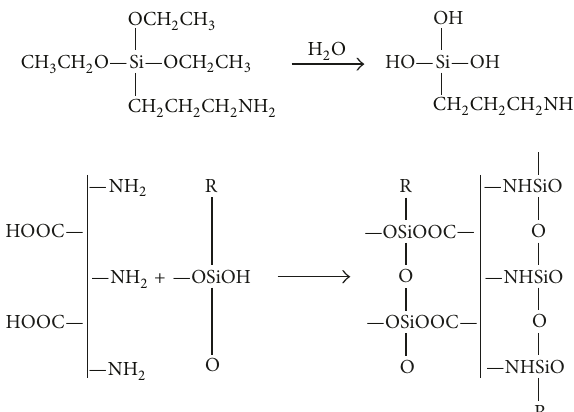
Figure 1: The reaction principle of the carboxymethyl chitosan crosslinking with